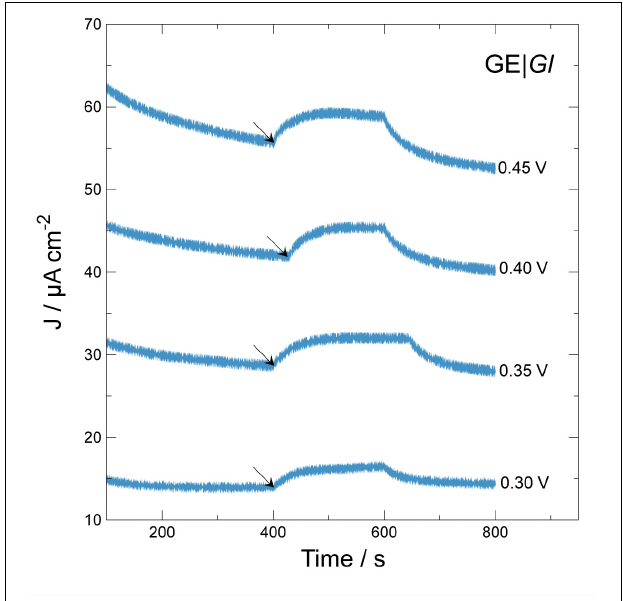
FIGURE 3 | Effect of applied potential vs. current density generation over time during chronoamperometric test using GE| Gl . Arrows indicate beginning of illumination step for 200 s. Applied potentials: 0.30 V; 0.35 V; 0.40 V; 0.45 V vs. Ag| AgCl| KCl 3.5